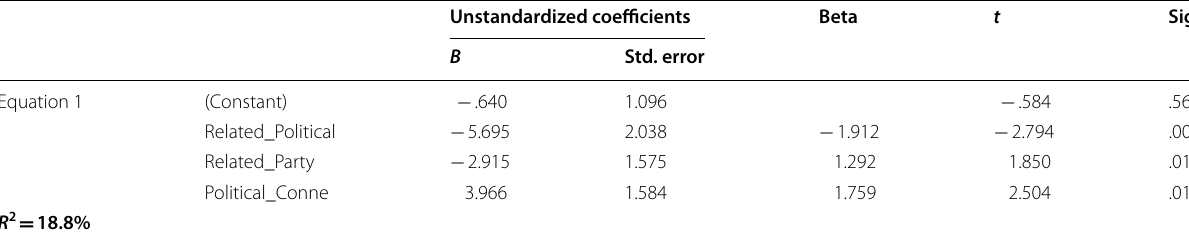
Table 6 Two‑stage least squares (2SLS) regression